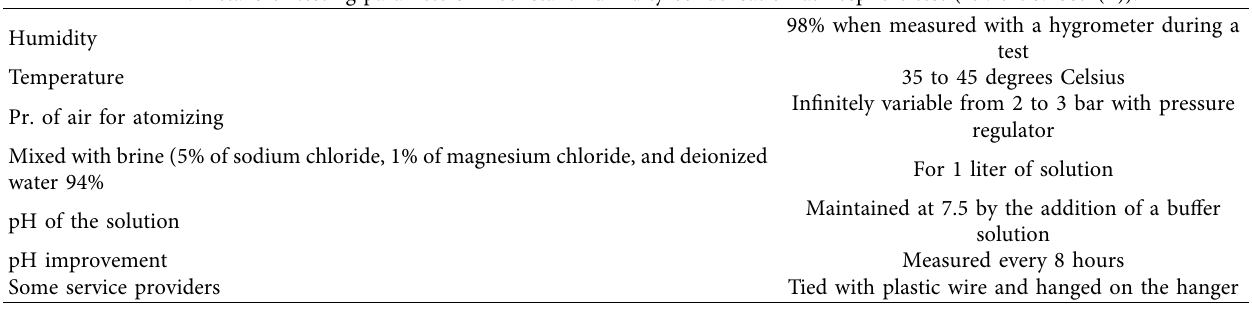
test 35 to 45 degrees